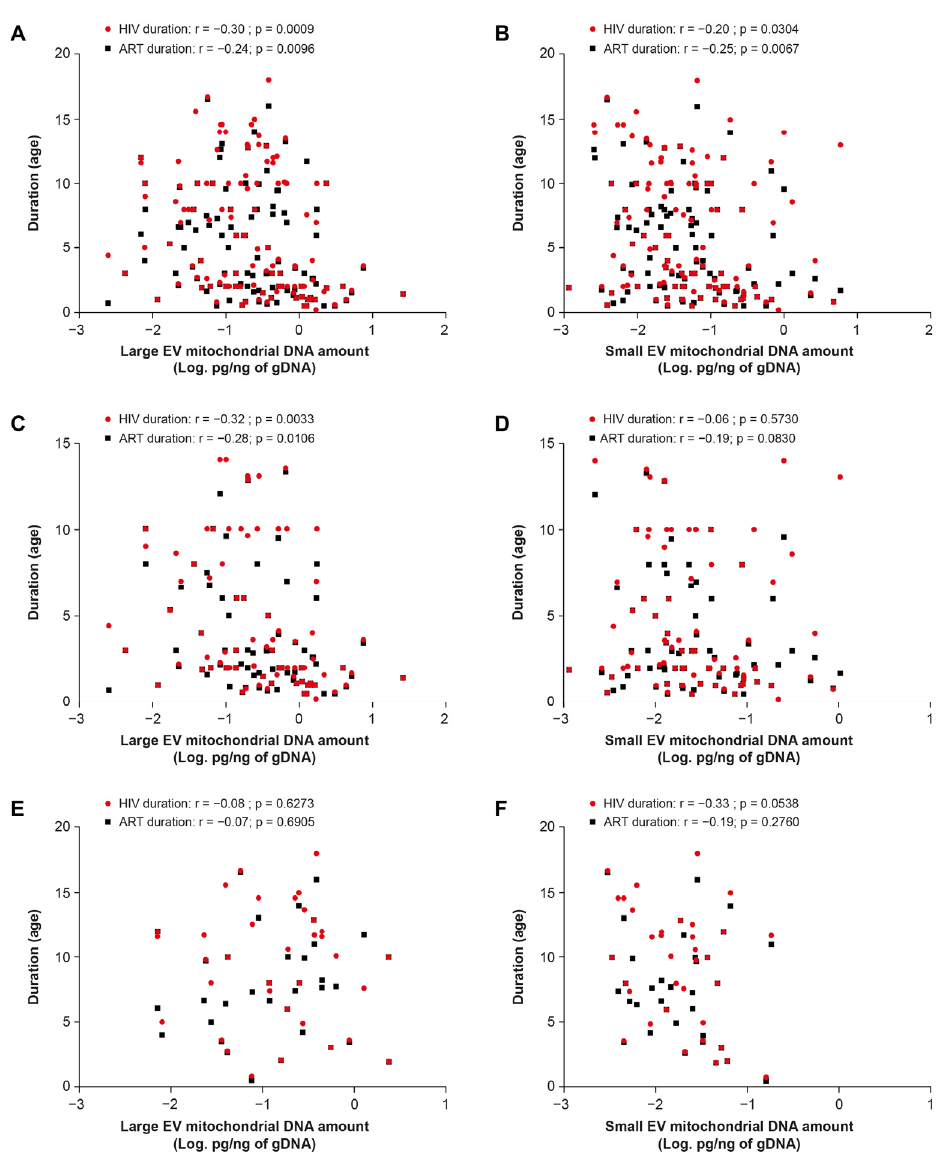
Figure 6. Pearson analysis of correlations between mtDNA abundance in large and small EVs of non-viremic participants and years of HIV+ status or years on ART. ( A , B ) ART without NRTI drugs; ( C , D ) Tenofovir-treated participants; ( E , F ) Zidovudine-treated participants. 2.5. The mtDNA Content of Large EVs Can Distinguish HIV+ Viremic